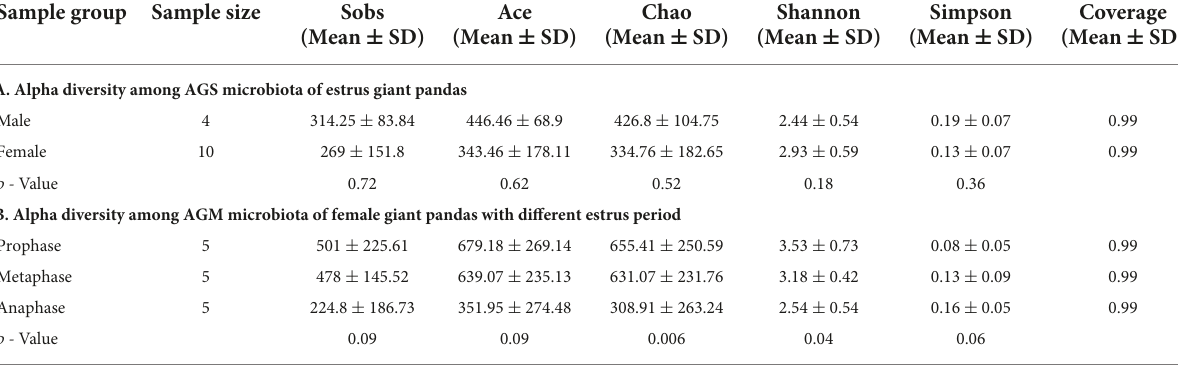
TABLE 1 Alpha diversity among AGS and AGM samples of giant pandas during estrus. Sample group Sample